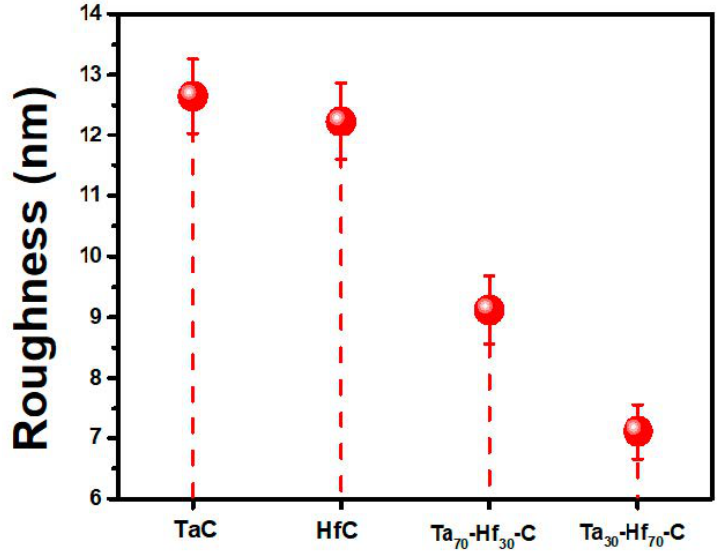
Figure 4. Roughness of the TaC and HfC individual coatings and [Ta 70 -Hf 30 -C] and [Ta 30 -Hf 70 -C] composite coatings.